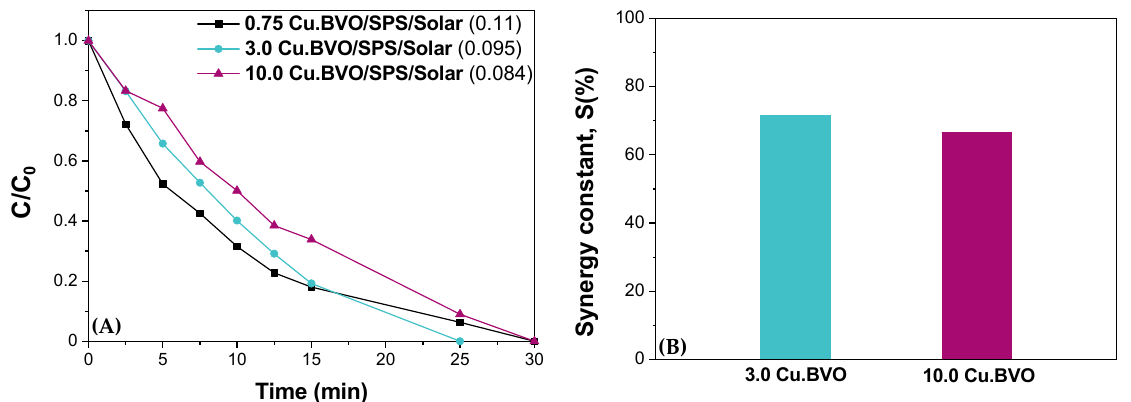
Figure 6. Effect of copper loading on ( A ) SMX removal and ( B ) synergy constant S in solar/SPS/catalyst systems in UPW.